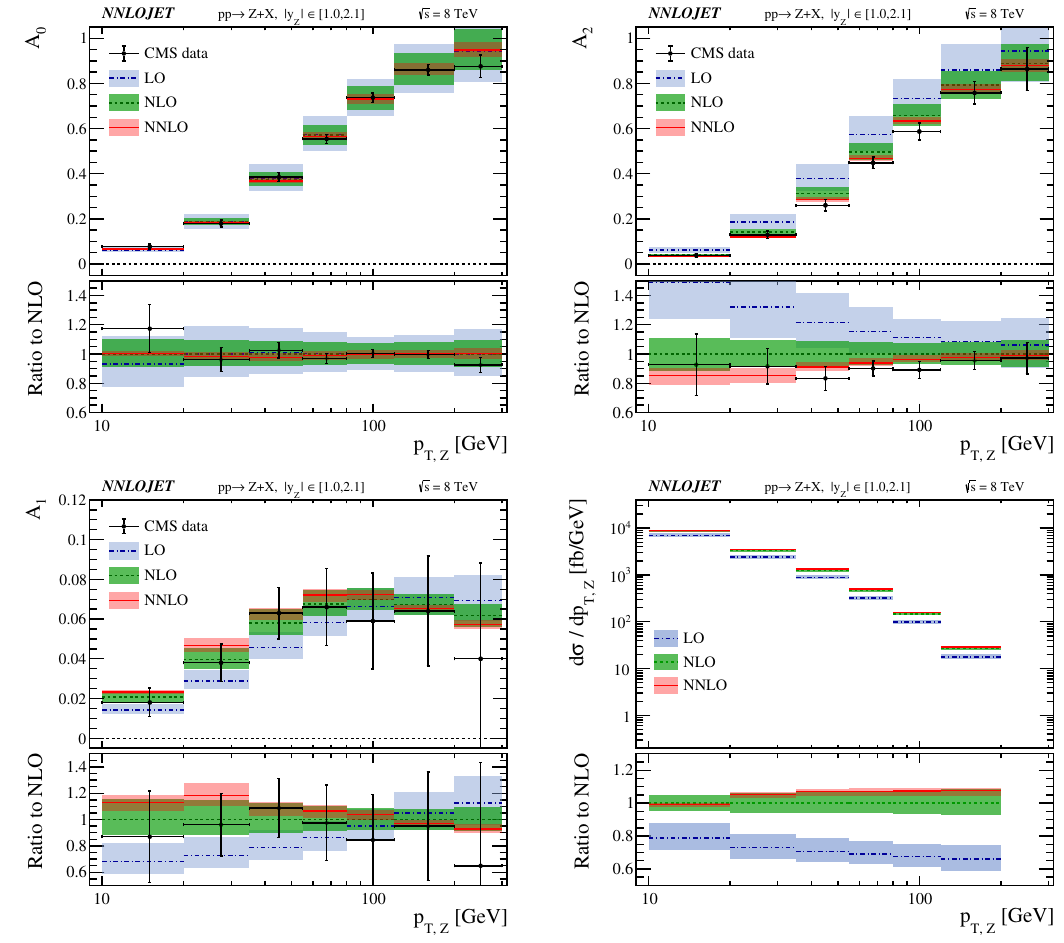
Figure 7 . The p T ; Z distribution for the angular coe(cid:14)cients A 0 (upper left), A 2 (upper right), A 1 (lower left), as well as the unpolarised cross section (lower right) in pp collisions at a kinematic cut of j y Z j 2 [1 : 0 ; 2 : 1] is required for all distributions. The CMS data (black points) are compared to the LO (blue (cid:12)ll), NLO (green (cid:12)ll), and NNLO (red (cid:12)ll) theoretical predictions. In the lower panel, each distribution is shown normalised with respect to the central NLO